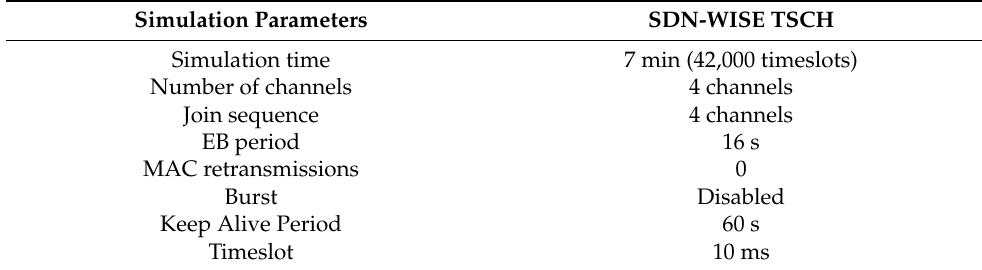
Table 2. TSCH parameters used in the simulation.